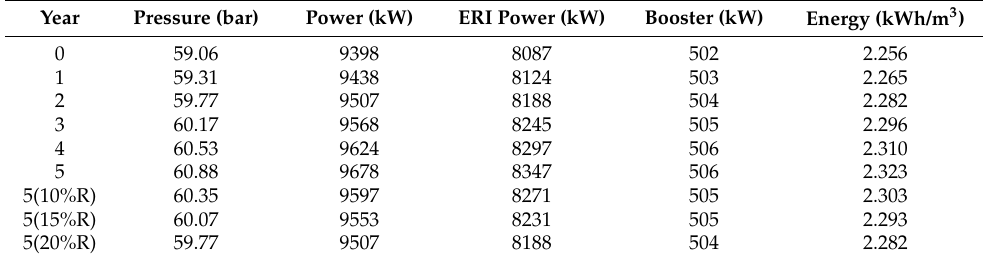
Table 10. Pressure, Power, and Energy consumption at 22 ◦ C.